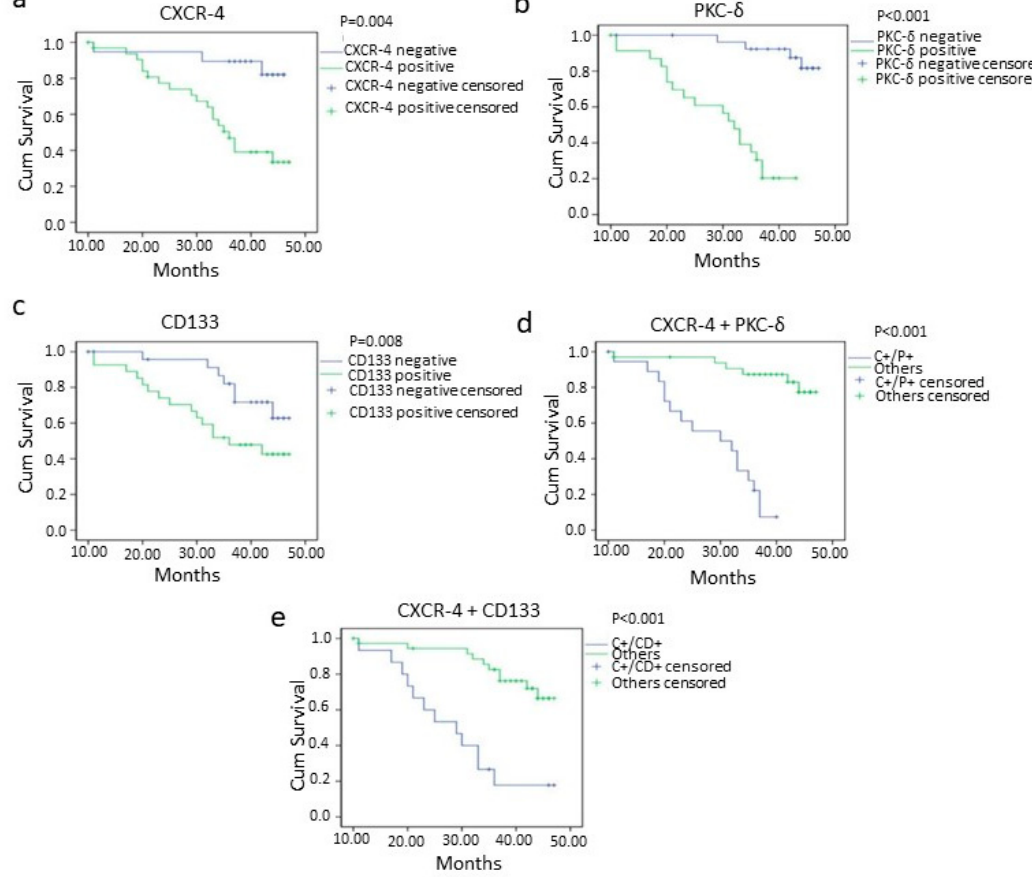
Figure 4. Overall survival of oral squamous cell carcinoma patients with CXCR-4 ( p = 0.004) ( a ), PKC- δ ( p = <0.001)